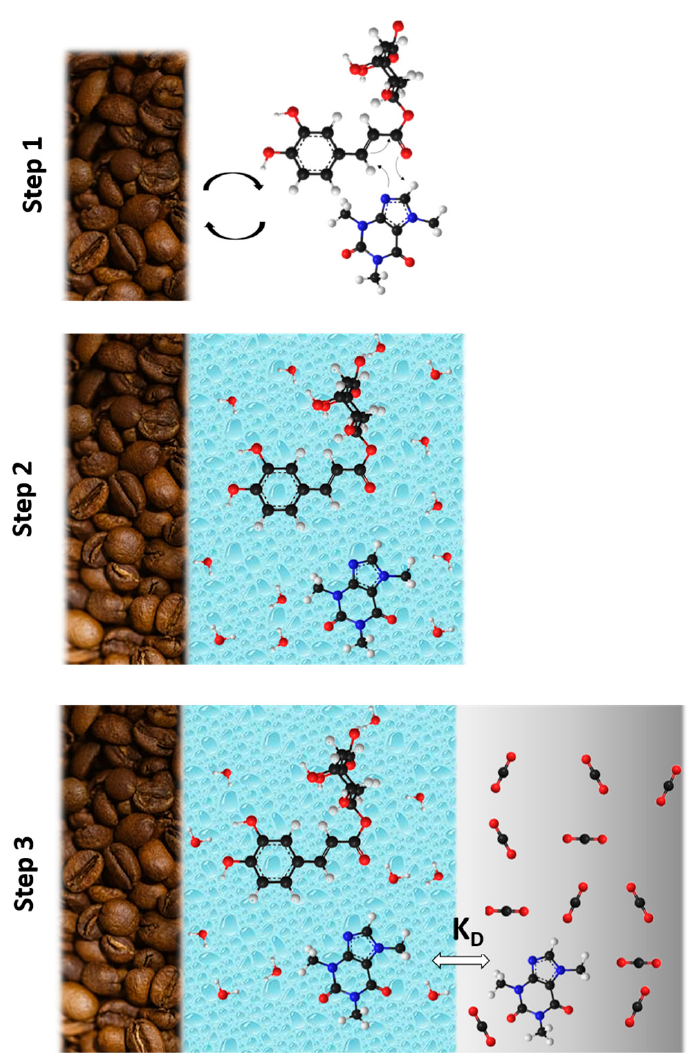
Figure 5. Mechanism of extraction of caffeine: step 1 --> no water, interactions between caffeine and chlorogenic acids and matrix, step 2 --> solubilization of caffeine in water, and step 3 --> SC-CO 2 /H 2 O liquid/liquid extraction of caffeine .